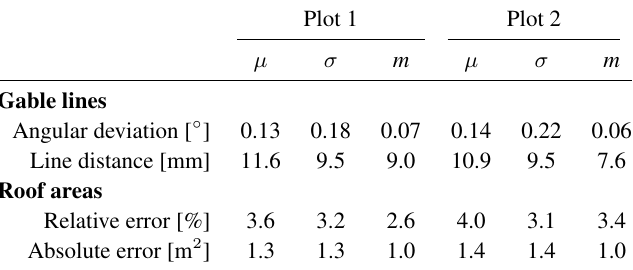
Figure 3. Orthophotographs depicting parts of (a) Plot 1 and (b) Plot 2. Green and red lines indicate, respectively, successfully matched and unmatched gable lines between the georeferenced and transformed datasets. Cyan and orange rectangles denote matched and unmatched roof plane facets. Table 1. Accuracy of gable line and roof polygon matching. µ , σ , m denote respectively the mean, standard deviation and median of the error